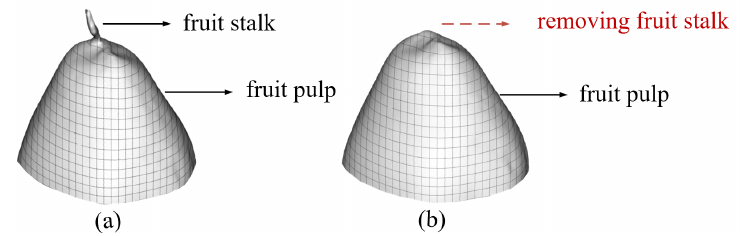
Figure 5. Comparison of the original pear head model and the segmented model. ( a ) Top of the original model. ( b ) Top of the model after segmenting fruit stalk and